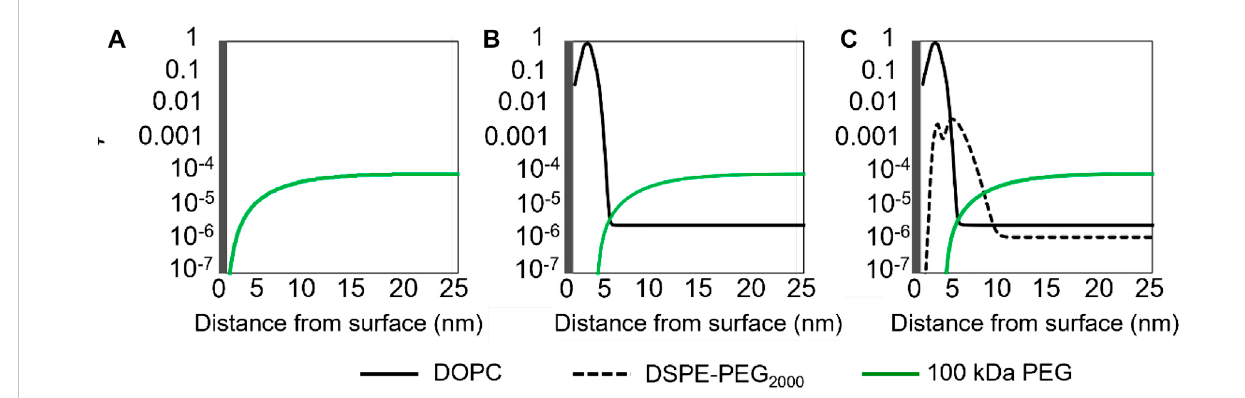
FIGURE 3 Spatial SCFT pro fi les predicting the interaction of 100 kDa PEG depletant at a fi xed bulk PEG volume fraction of φ = 10 – 4 (green) with (A) bare silica spheres, (B) DOPC CSLBs (black) and (C) DOPC + DSPE-PEG 2000 CSLBs (dashed black lines). The silica surface is indicated by the grey region. The phospholipid density pro fi les resulting from the SCFT computations (B, C) seem to suggest a thin water-rich layer of a few nm between the lipid bilayer and the bulk; the lipid concentration attains a maximum value a few nm from the silica